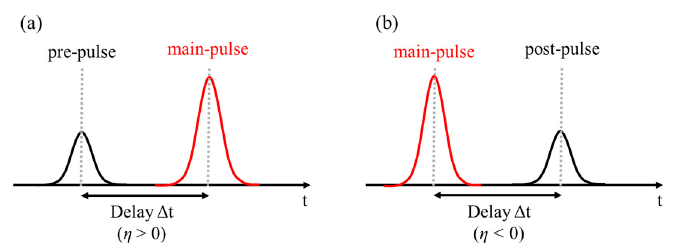
Figure 2. Schematic diagram of nanosecond dual-pulse temporal shaping. ( a ) Ramp-up shape with pre-pulse and main-pulse; ( b ) Ramp-down shape with main-pulse and post-pulse. pre-pulse and main-pulse; ( b ) Ramp-down shape with main-pulse and